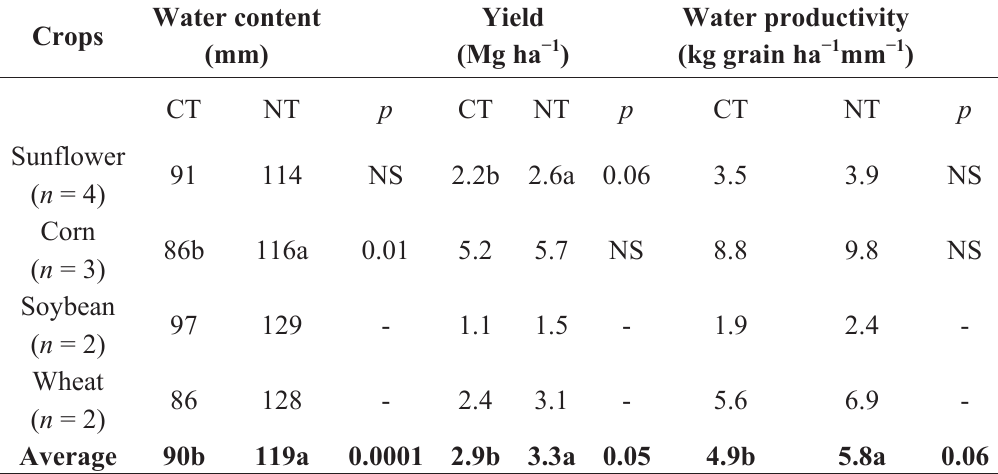
Different letters indicate significant differences (paired t -test) between CT and NT for each variable and